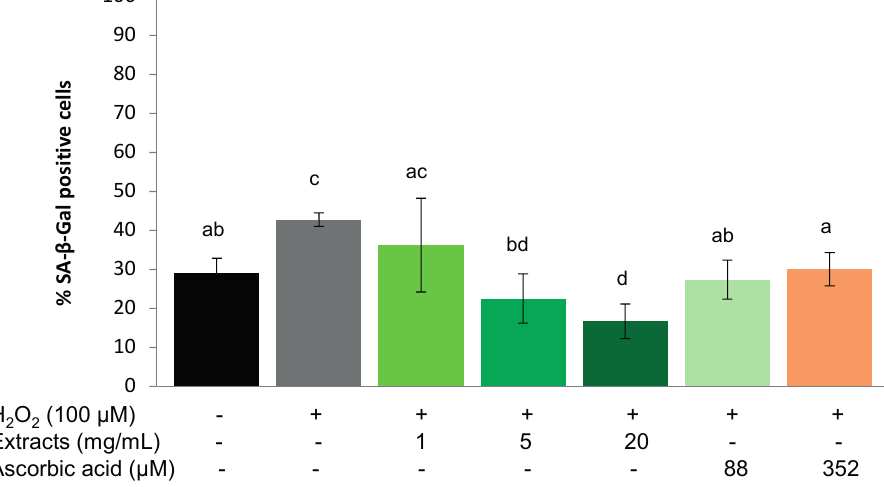
Figure 6. Protective effect of S. oleraceus leaf extracts on WI-38 cells chronically treated with H 2 O 2 . Cells were treated with 1, 5 or 20 mg/mL S. oleraceus leaf extracts or 88 or 352 µM ascorbic acid for 1 h at day 1 before being stressed with 30 µM H 2 O 2 1 h per day for five consecutive days. Data are shown as percentage of SA- β -Gal positive cells (mean ± SD, n = 6). Bars with no letters in common are significantly different ( p < 0.05)